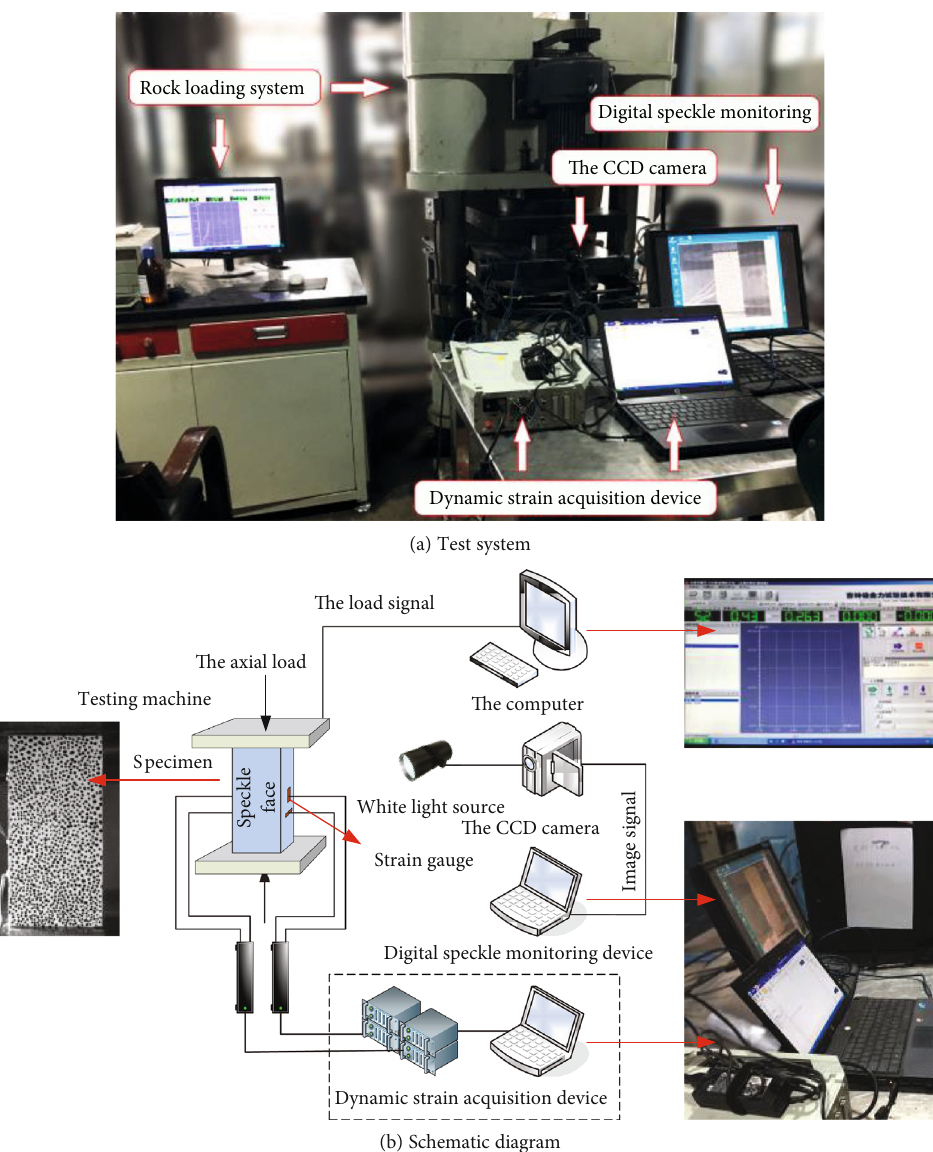
Figure 2: Test system and its schematic